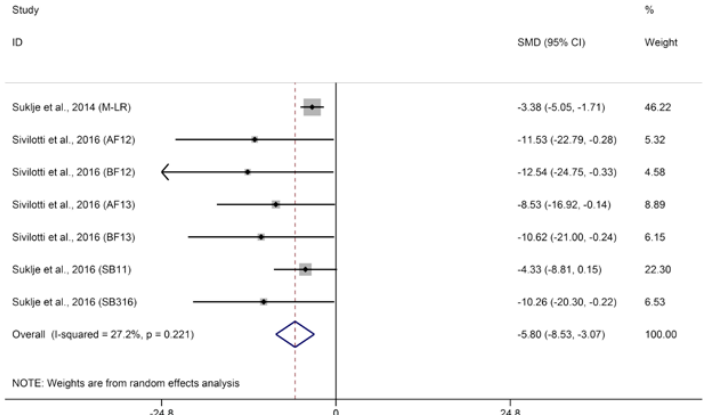
Figure 3. Meta-analysis for the effects of basal defoliation on 3-isobutyl-2-methoxypyrazine (IBMP) in wine.